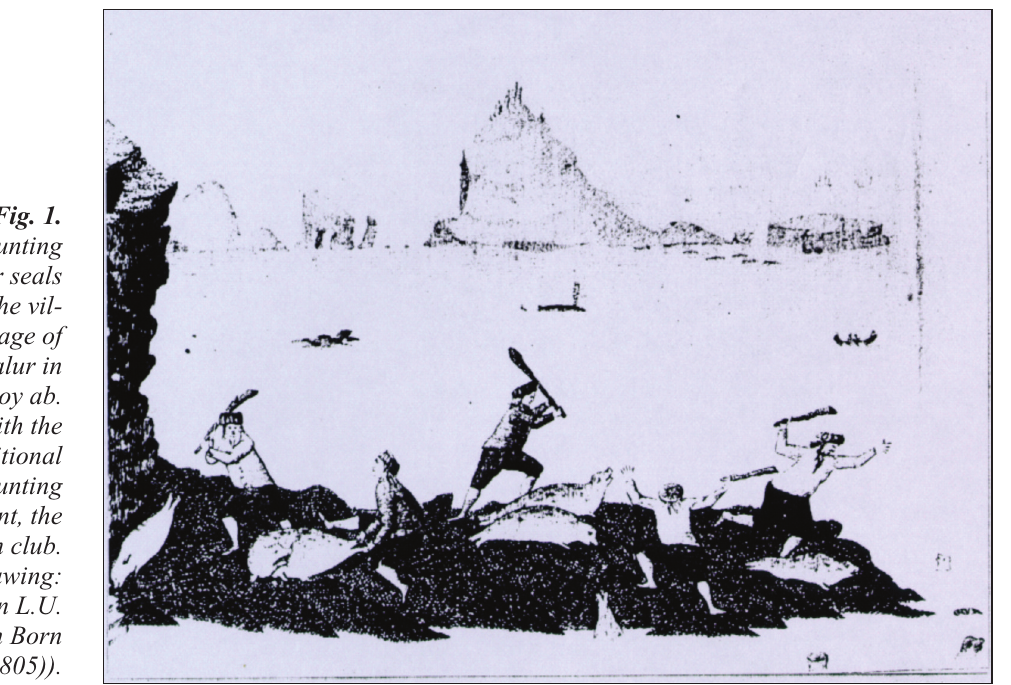
Men hunting harbour seals near the vil- lage of Gásadalur in Vágoy ab.